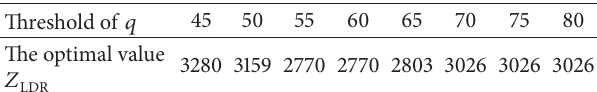
Table 2: The relationship between threshold and the optimal